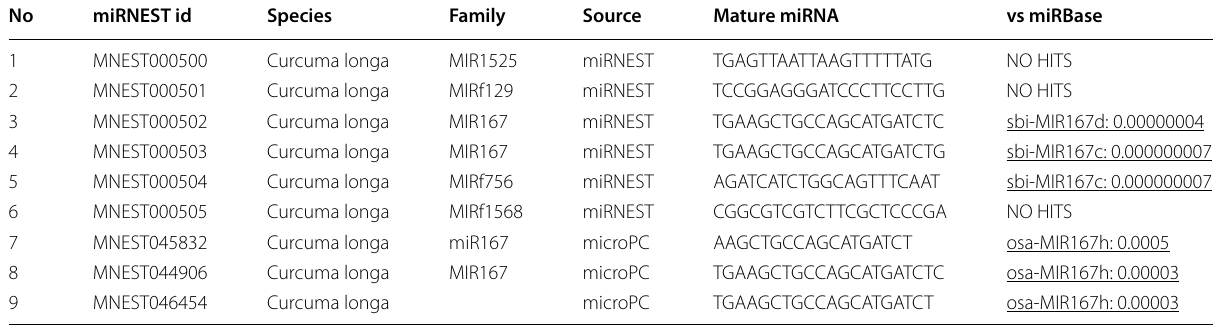
Table 1 List of predicted C. longa miRNAs using miRNEST 2.0